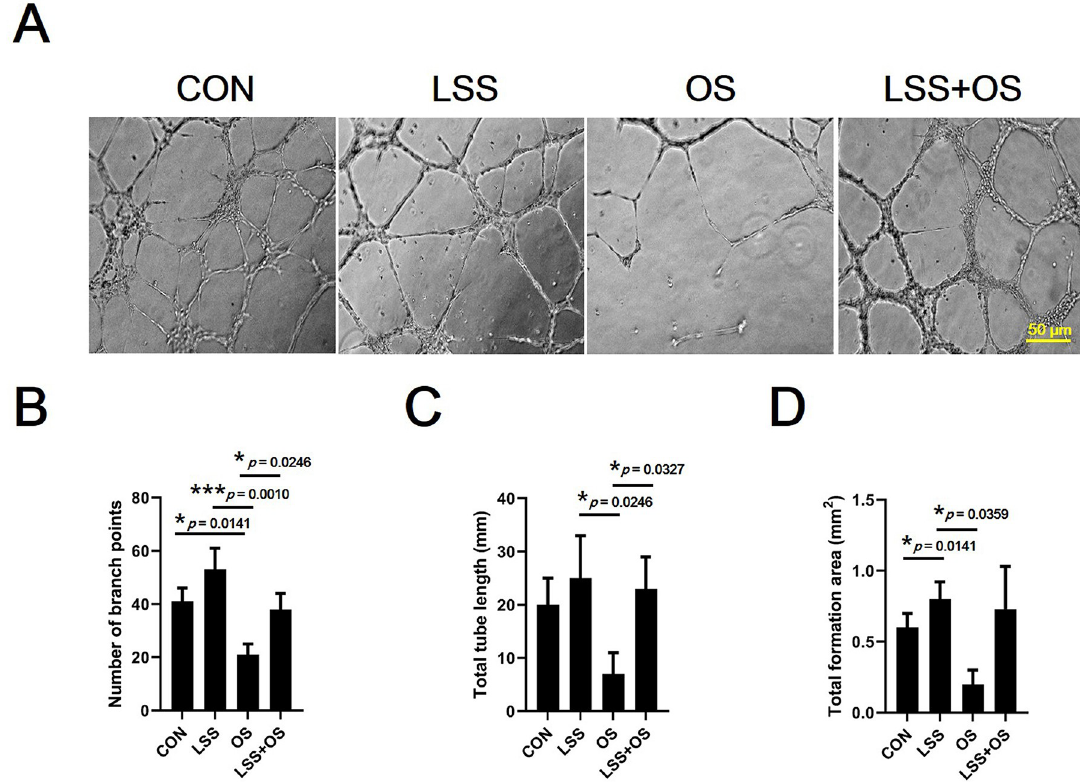
Fig 9. Comparison of tube formation ability of vascular ECs after senescence simulated by oxidative stress and exercise simulated by laminar shear stress in vitro . (A) 10 × magnification microscopic images of tube formation assay. (B) Number of branch points. (C) Total tube length. (C) Total formation area. LSS: Laminar shear stress; OS: Oxidative stress. All data are presented as the mean ± SD, � p < 0.01 and ��� p < 0.001.